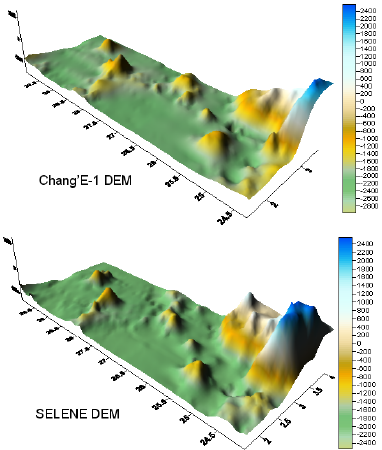
Figure 6. Interpolated DEM with the same resolution of 1200 m using Chang’E-1 and SELENE laser altimetry data at the Apollo 15 landing site area, respectively.